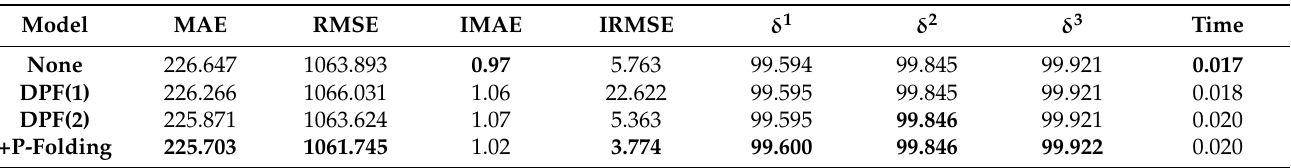
Table 4. The ablation experiments of the dense progressive fusion module and the point folding module. The bold numbers are the